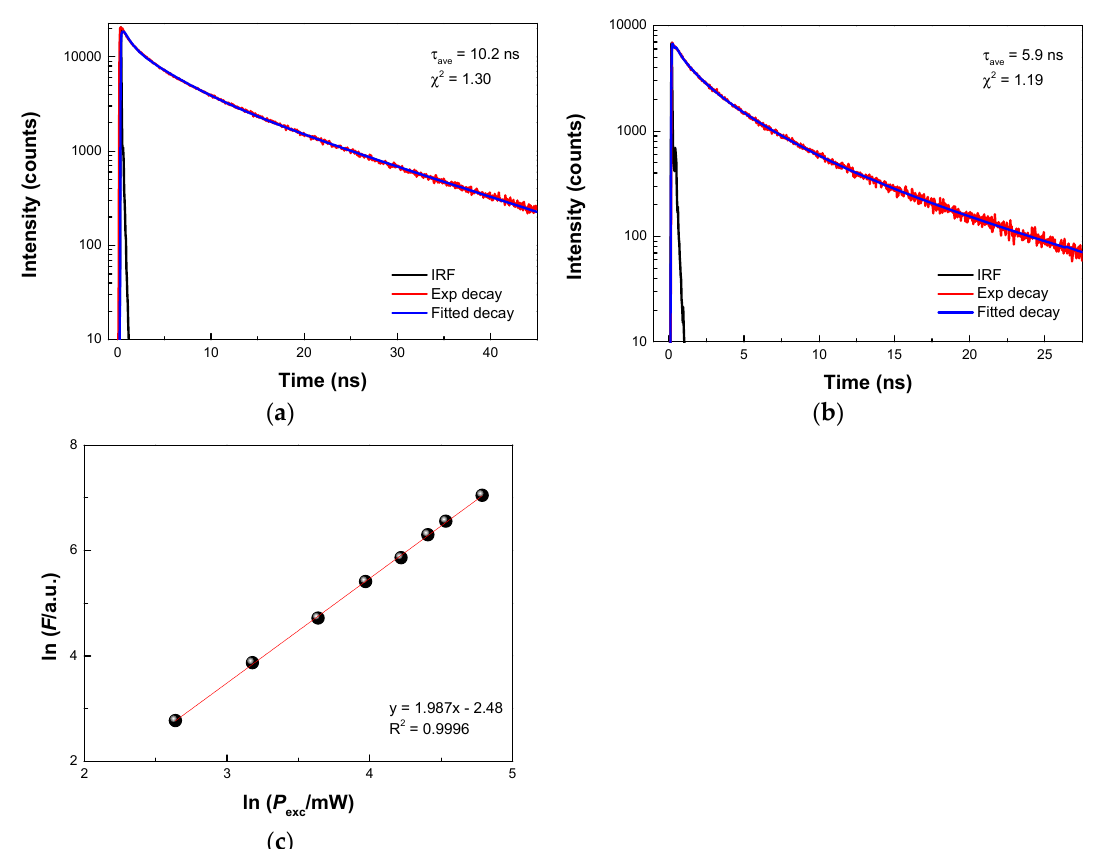
Figure 8. Time-resolved intensity decays of aqueous solutions of WP-CDs-5 under excitations at 340 nm ( a ) and at 620 nm ( b ), both emissions being observed at 430 nm; ( c ) demonstration of the quadratic dependence of emission characteristic of two-photon absorption by plotting the logarithm of fluorescence intensity (F) vs. the logarithm of the average excitation power ( P exc ). Excitation at 620 nm, emission at 430 nm.